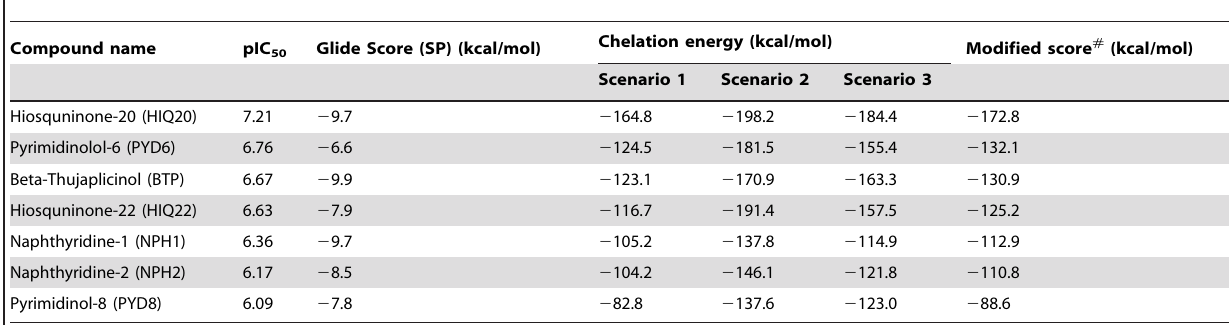
Table 2. Summary of experimental and calculated energies of binding of HIV-1 RNase H